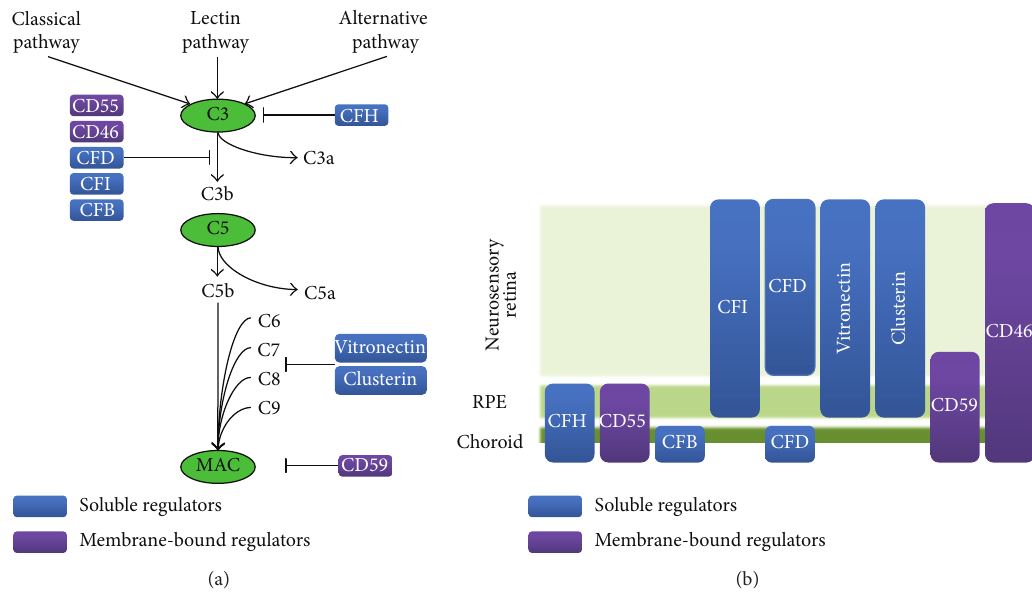
Figure 1: (a) Complement system activation. Local effects of the inhibitors on complement components. (b) Complement system in the eye. Local production of the complement inhibitors by retinal